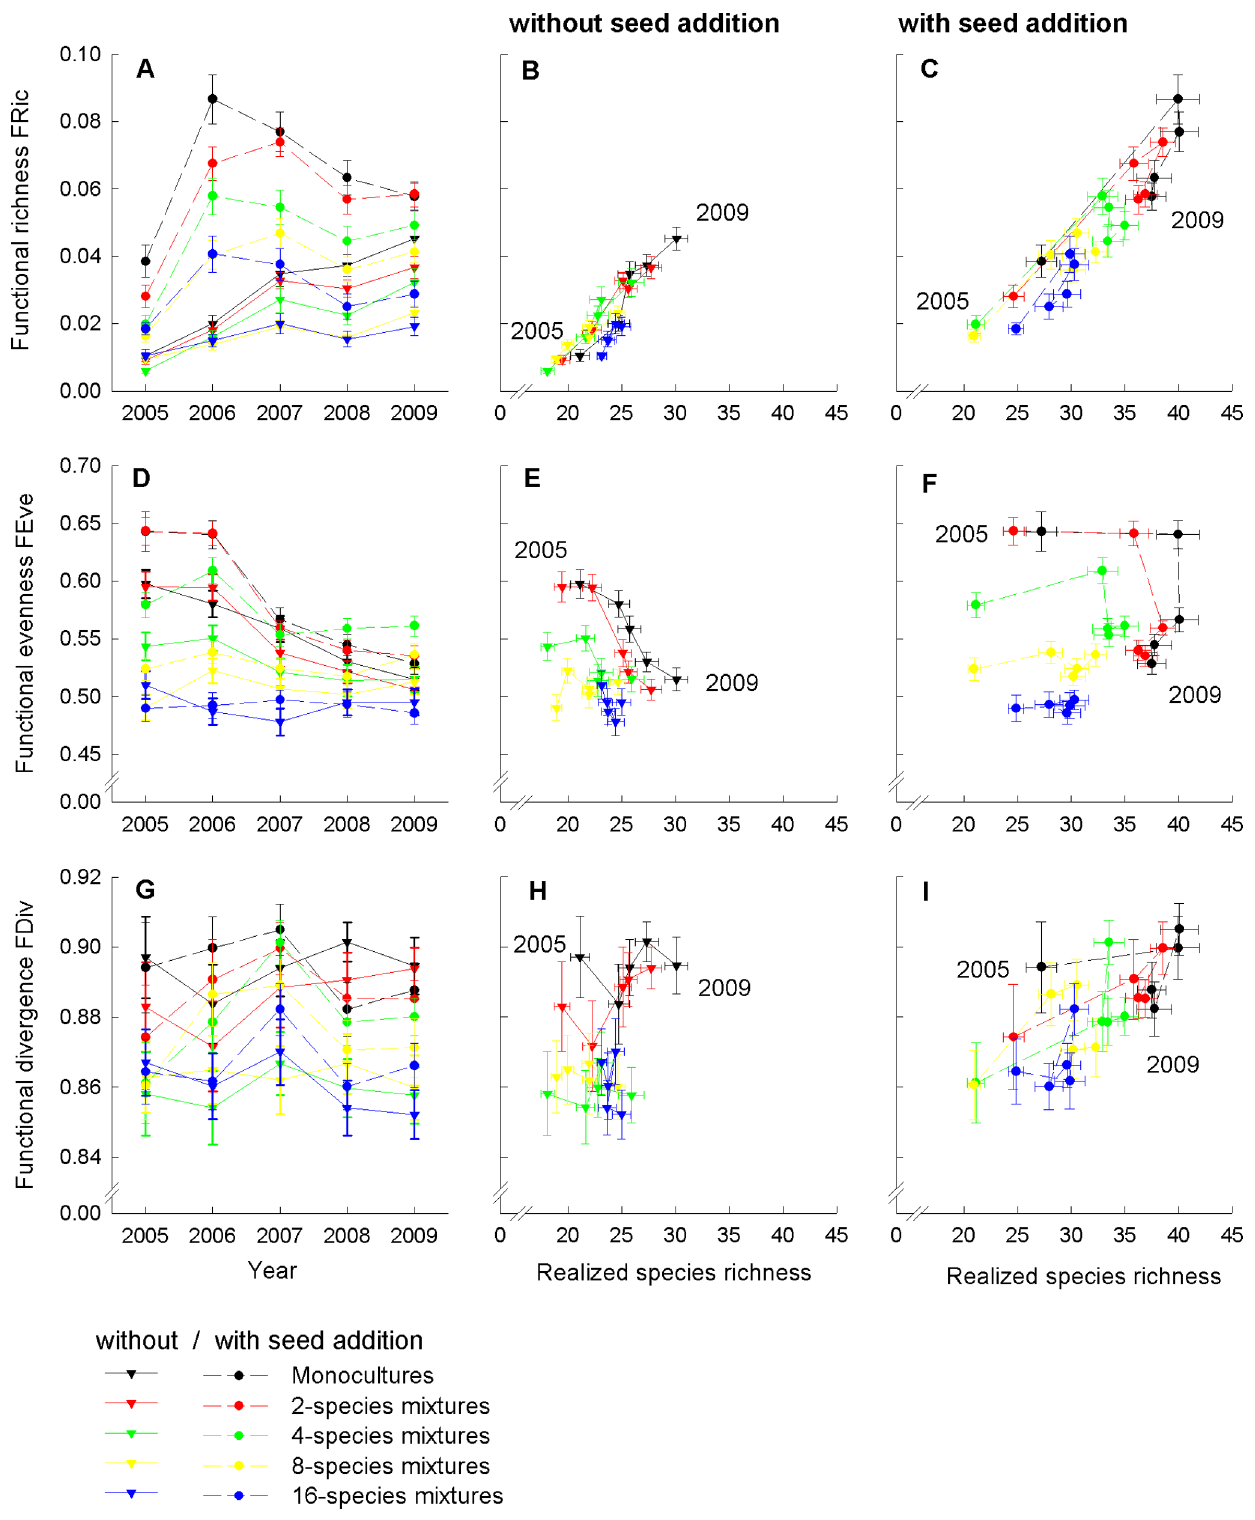
Figure 3. Functional richness (FRic), functional evenness (FEve) and functional divergence (FDiv) per initial species-richness level. FRic as a function of time (A), and plotted against realized species richness (B, C), FEve as a function of time (D), and plotted against realized species richness (E, F), and FDiv as a function of time (G), and plotted against realized species richness (H, I) as mean values ( 6 1SE) per initial species-richness level across colonization periods. Treatments without seed addition are shown in (B, E, H), and treatments with seed addition are shown in (C, F, I).